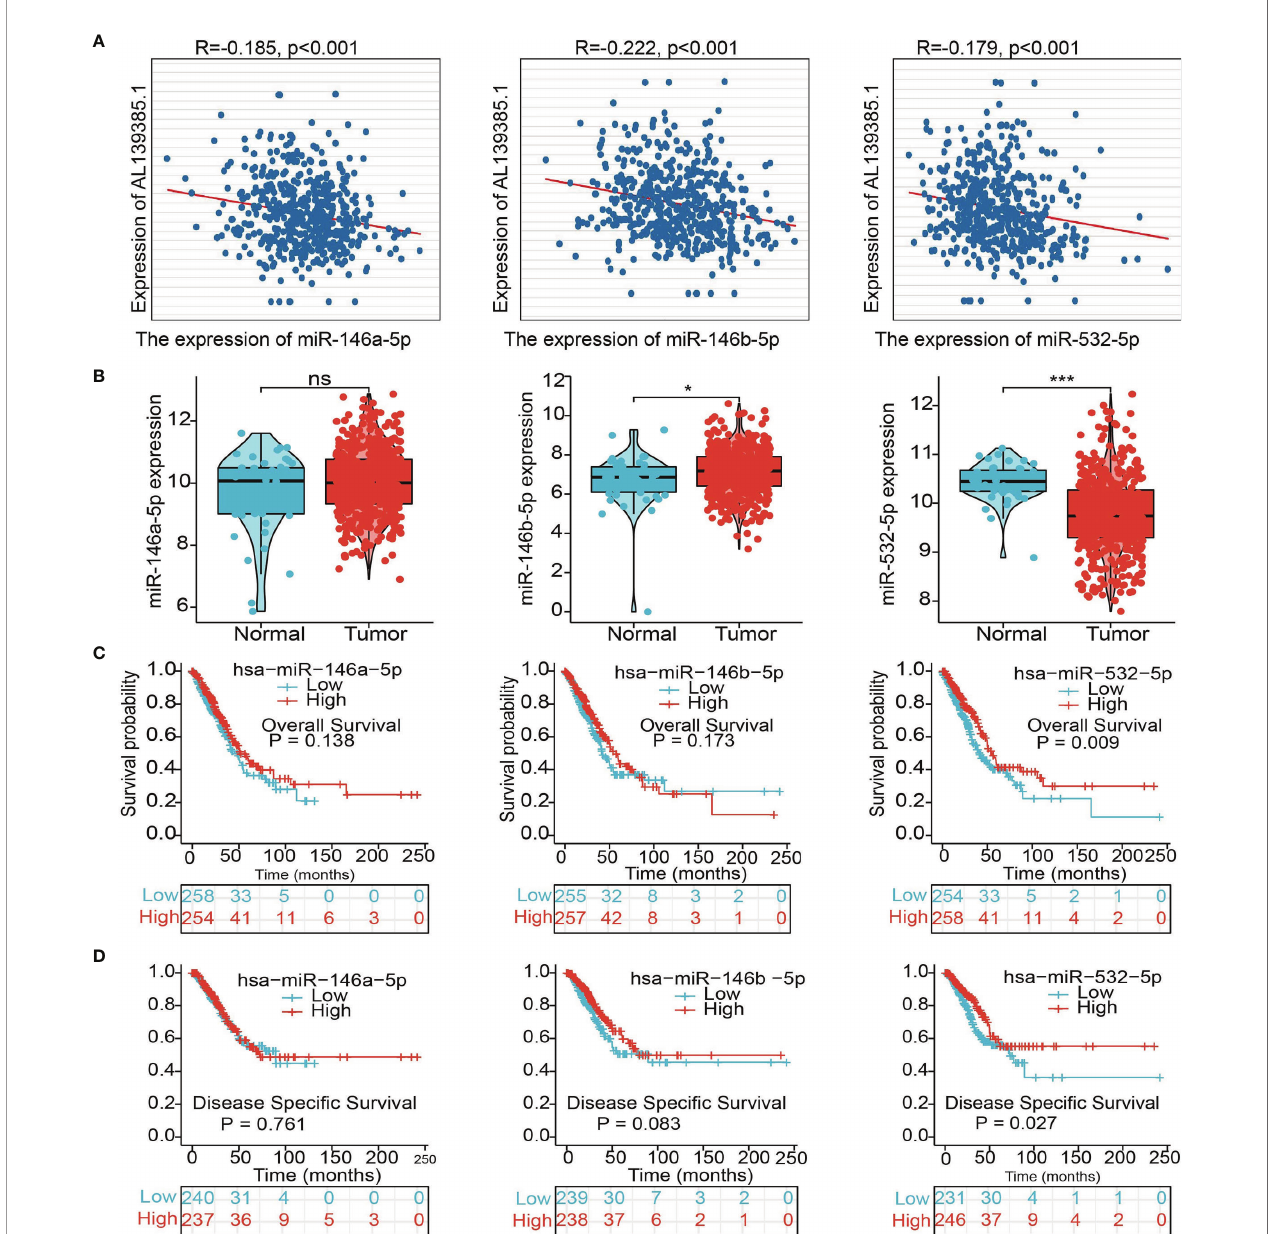
FIGURE 7 | Analysis of the potential miRNAs of AL139385.1. (A) Analysis of the correlations between AL139385.1 expression and miR-146a-5p, miR-146b-5p, and miR-532-5p in TCGA-LUAD. (B) Analysis of miR-146a-5p, miR-146b-5p, and miR-532-5p expression in lung cancer and adjacent normal tissues in the TCGA database. (C, D) Association between miR-146a-5p, miR-146b-5p, and miR-532-5p expression and outcomes of patients with LUAD. NS: P> 0.05,*P<0.05, and